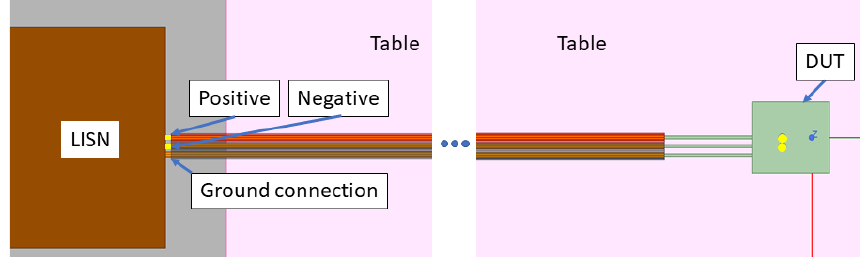
Figure 8. The impedance diagram of the harness model.